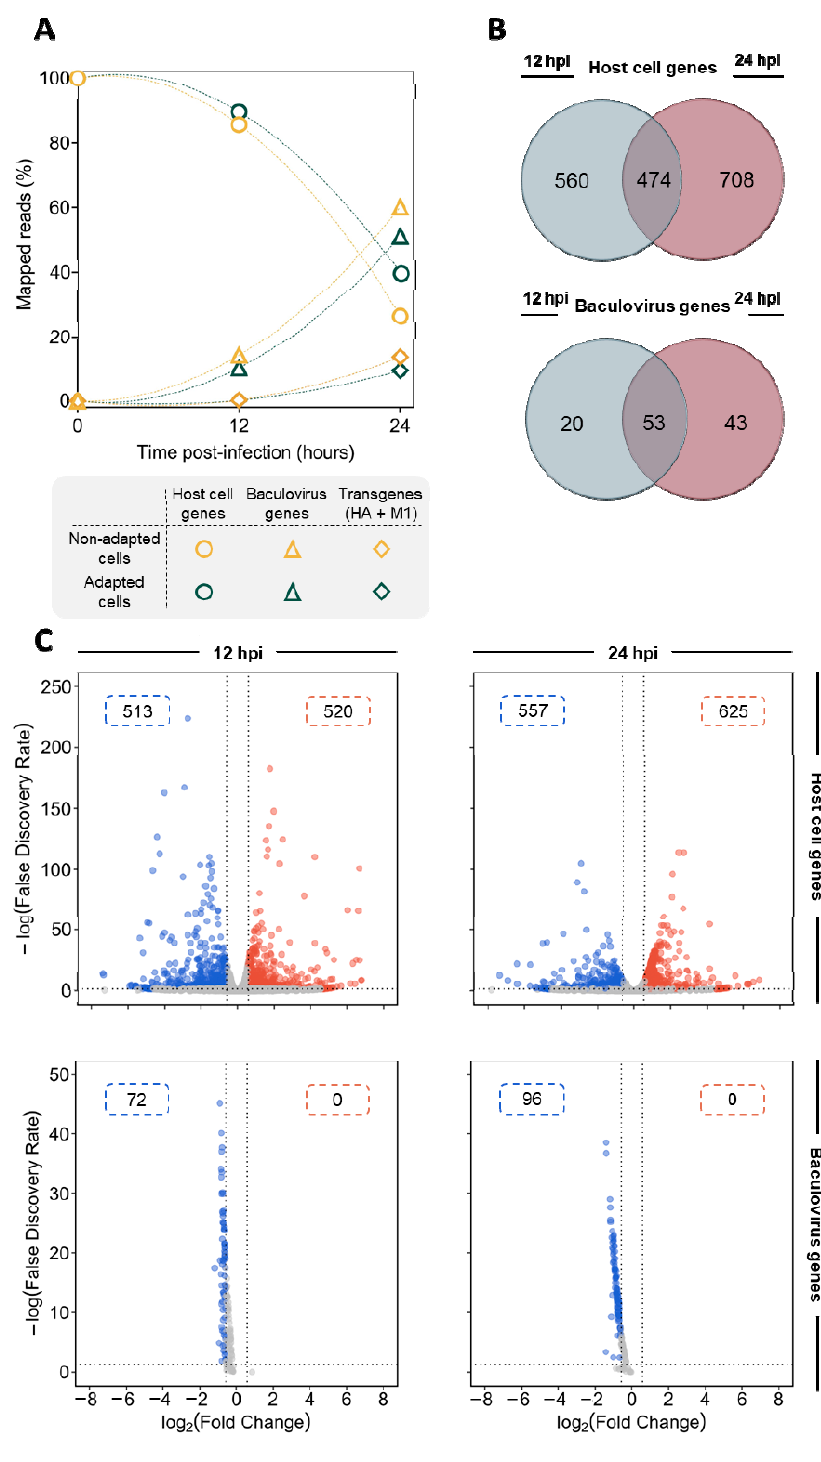
Figure 2. Differential gene expression analysis. ( A ) Percentage of reads mapping to host cell (circles), baculovirus (triangles) and transgenes (diamonds) throughout infection. ( B ) Venn dia- gram showing the number of host-cell and baculovirus genes being differentially expressed (|log2 (Fold-Change| > 0.58 and FDR < 0.05) between adapted and non-adapted cells, at 12 hpi, 24 hpi, and both timepoints simultaneously. ( C ) Volcano plot showing the distribution of differentially expressed genes with higher (in red) or lower (in blue) expression in adapted cells, compared to non-adapted cells. Number in boxes: number of differentially expressed